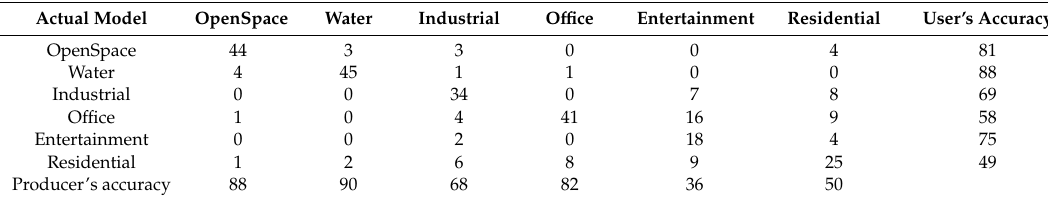
Table A1. Confusion matrix of decision tree classified map using remote sensing only.